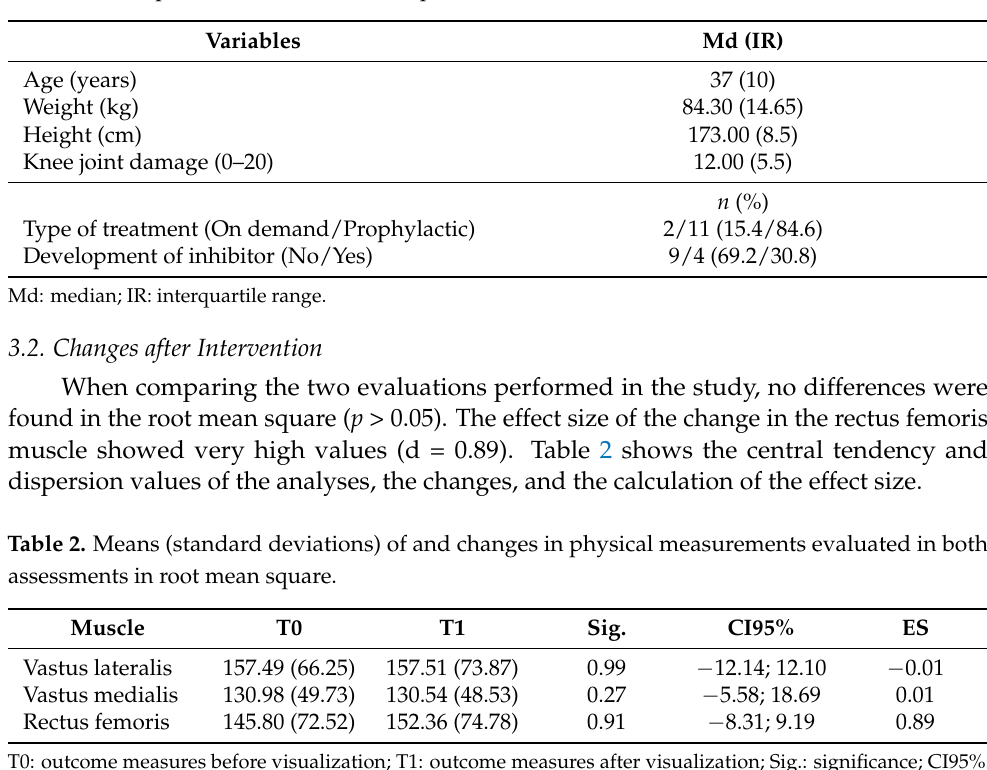
Table 1. Descriptive characteristics of the patients.